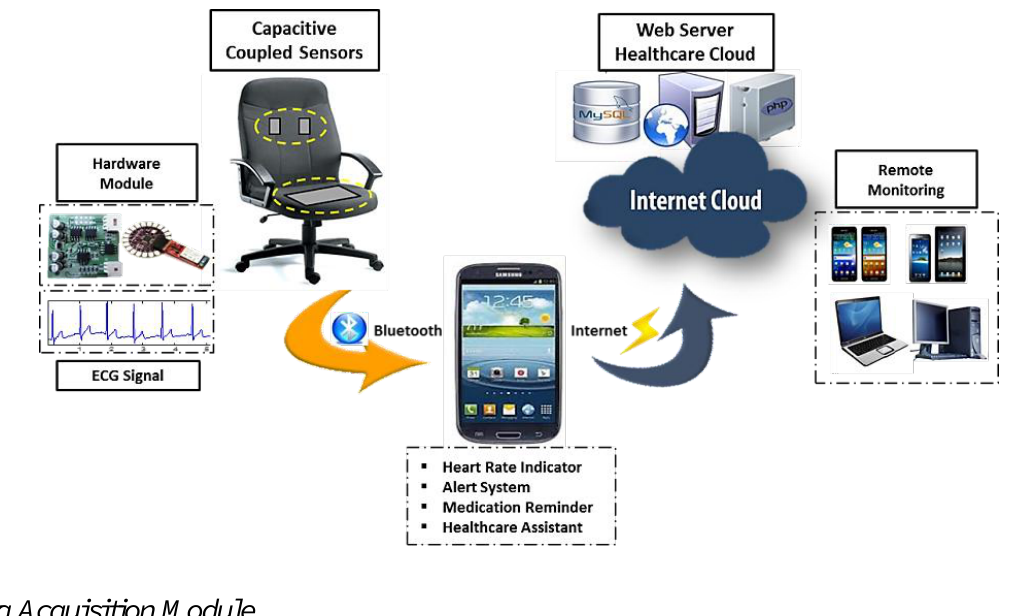
Figure 3. System design of mobile healthcare and cloud-based service for noncontact ECG monitoring system, which consists of a data acquisition module, a mobile system, and a cloud computing Web server module.